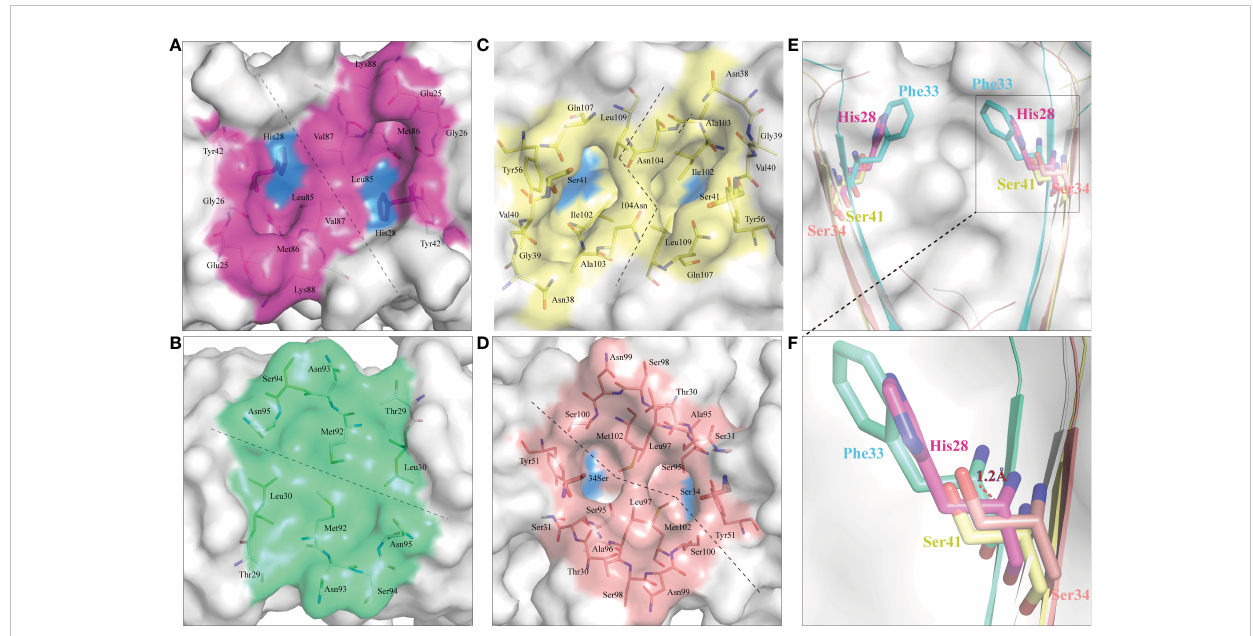
FIGURE 7 Sc CD8 aa possess a canonical binding cavity. The composition of the binding cavities in representative vertebrate CD8 aa structures are shown. Molecular surfaces are rendered in white, with residues key to dimeric interaction highlighted blue. (A) The cavity of Sc CD8 aa , the side chains of cavity residues are shown as sticks and colored magenta. (B) The cavity of grass carp CD8 aa , the side chains of cavity residues are shown as sticks and colored lime green. (C) The cavity of chicken CD8 aa , the side chains of cavity residues are shown as sticks and colored yellow. (D) The cavity of human CD8 aa , the side chains of cavity residues are shown as sticks and colored pink. (E, F) Comparison of key amino acids in the cavity of CD8 aa structure in selected species, the residues and the distance between His28 and Phe33 are